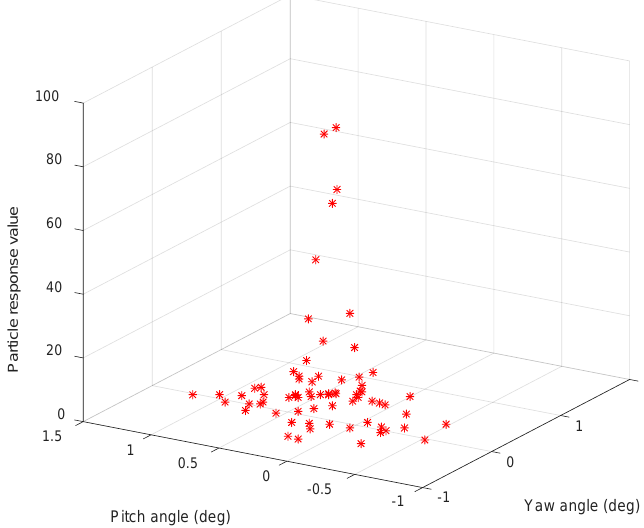
Figure 8. Base-station sampling responses of the ith CCR at time t.